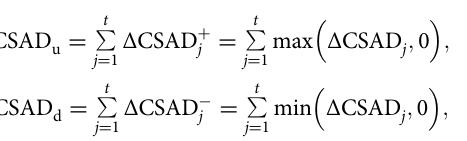
where E u and E d are high and low internet postings, respectively.